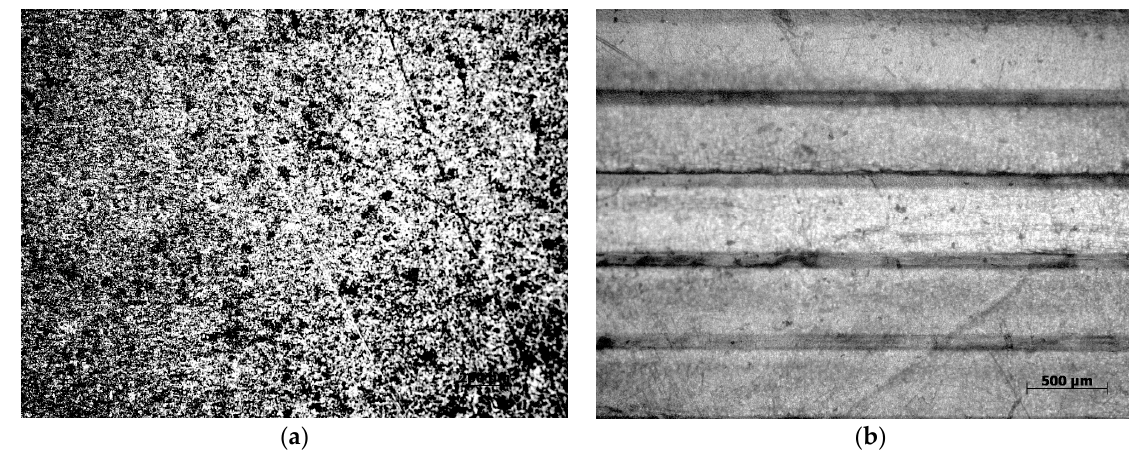
Figure 5. Optical Micrograph (OM) images of the ( a ) Ni-Ti ribbon and ( b ) poly (methyl methacrylate)- Ni-Ti ribbon composite.